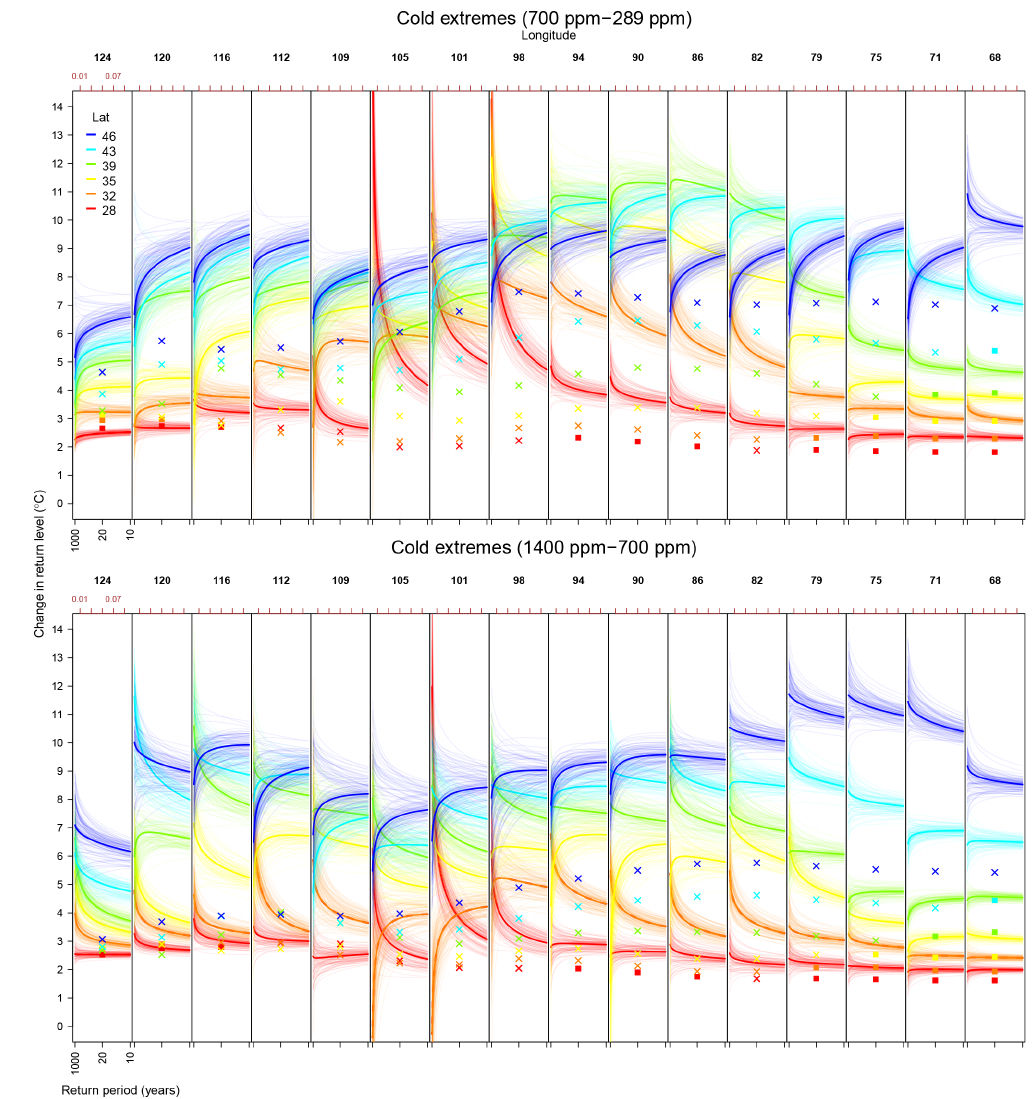
Figure 8. As in Fig. 7 but for annual temperature minima. Crosses and boxes now give wintertime mean changes. Note that the return period axis is now flipped so that longer return periods are on the left. In general, cold extremes warm more than do winter means, especially at high latitudes.